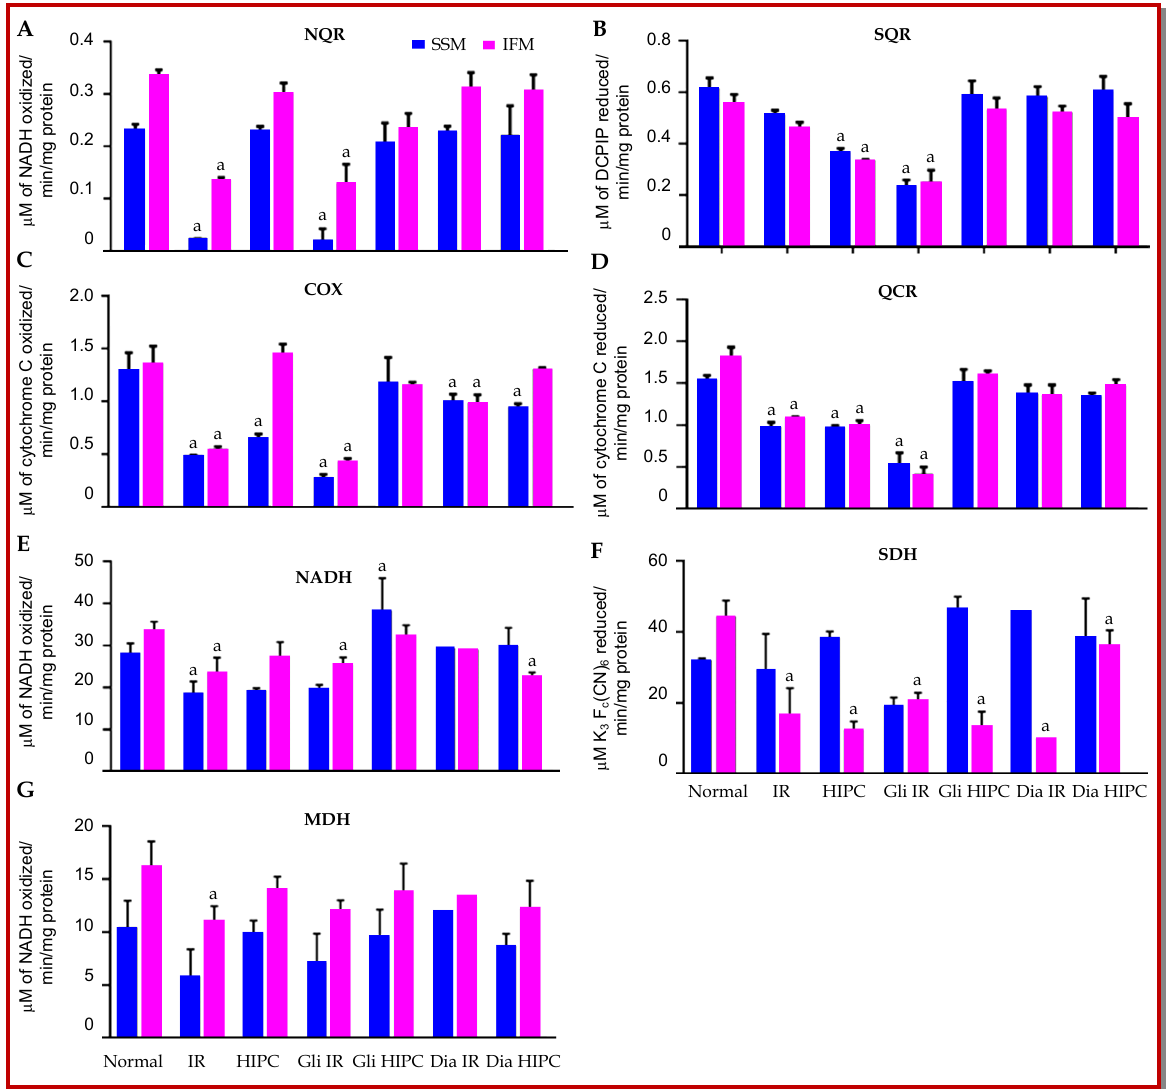
Figure 3: Effect of hydrogen sulfide and K ATP modulators on cardiac mitochondrial enzyme activities: Effects of hydrogen sulfide on mitochondrial functional activities in the presence of K ATP modulators were evaluated from the mitochondrial enzyme and electron transport chain enzyme activities: (A) NQR, (B) SQR, (C) COX and (D) QCR (E) NADH, (F) succinate dehydrogenase (SDH), (G) malate dehydrogenase (MDH). Results are expressed as mean ± SD of n=6 rats/group. a Statistically significant from normal perfusion (p<0.05) from the normal